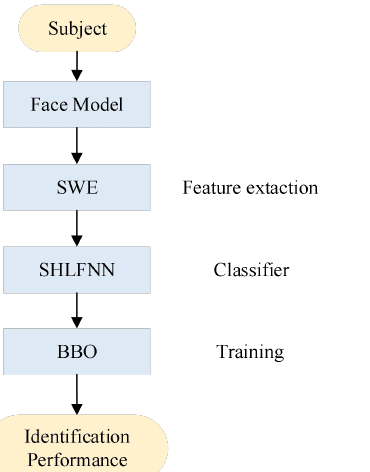
Figure 6. Block diagram of our developed system